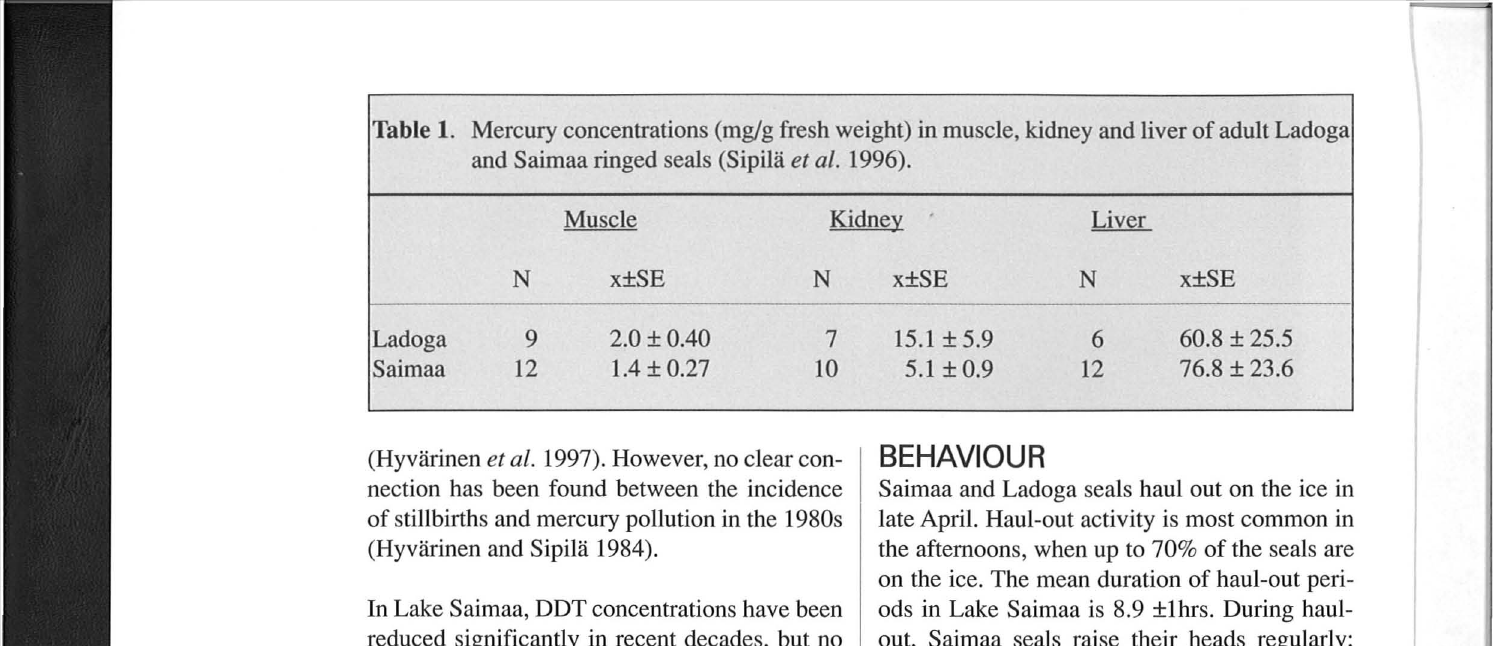
Table 1. Mercury concentrations (mg/g fresh weight) in muscle, kidney and liver of adult Ladoga and Saimaa ringed seals (Sipilli et al. 1996). Muscle Kidney